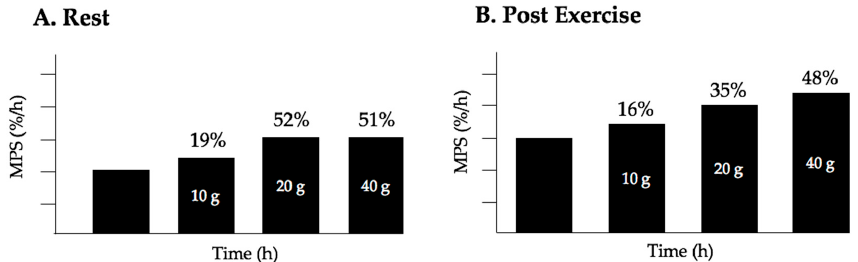
Figure 2. Whey protein ingestion-induced increase in MPS in young men, percent change from 0 g. ( A ) At rest, consumption of 10 g or 20 g of protein results in a rise of 19% and 52% respectively from 0g. Consumption of 40 g of whey protein does not result in superior stimulation of MPS beyond consumption of 20 g; ( B ) Following resistance exercise, consumption of 20 g of protein increases MPS almost twice as much as consumption of 10 g, while consumption of 40 g of whey protein results in a small stimulation of MPS over and above that seen at 20 g indicating there are diminishing returns in terms of stimulation of MPS above 20 g. Data redrawn from Witard et al. [35], however, similar data are reported by MacNaughton et al. [38], and Moore et al.